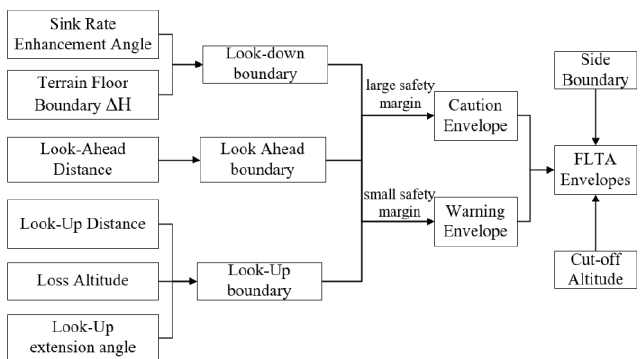
Figure 1. Examples of FLTA caution and warning envelopes.